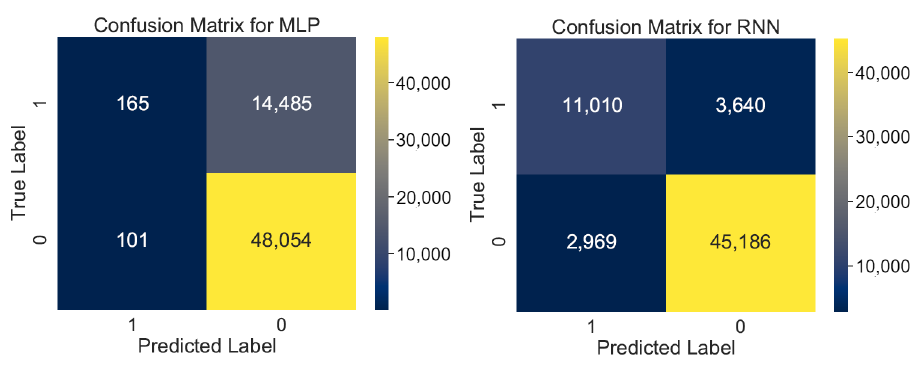
Figure 7. Confusion matrix for MLP and RNN.